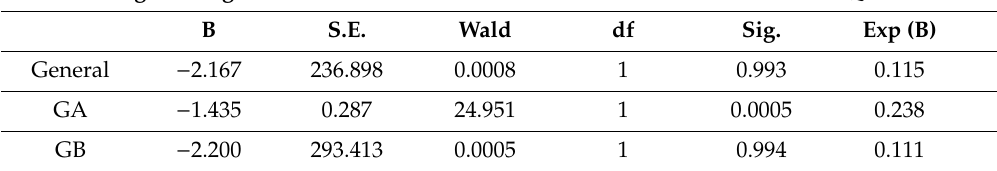
Table 2. Results of the logistic regression analysis in the SF-36 health-related quality of life survey following surgical repair of the cystocele.